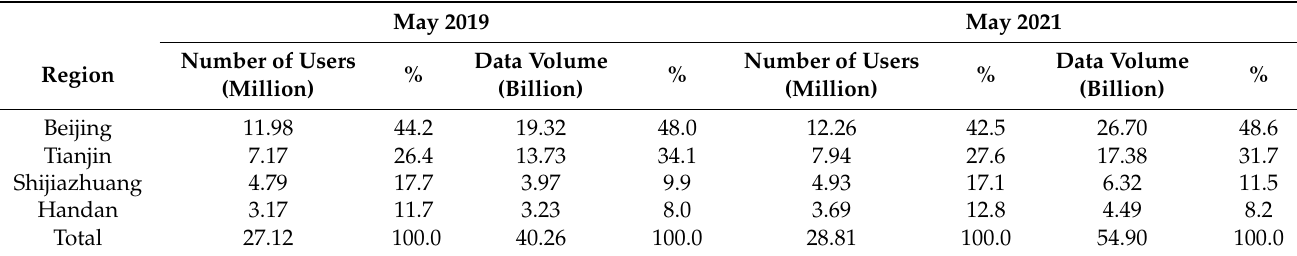
Table 1. The data size.